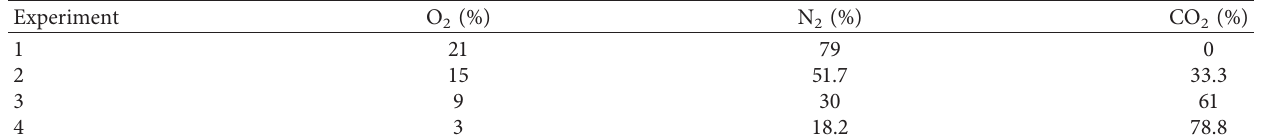
2 concentration (% by volume).